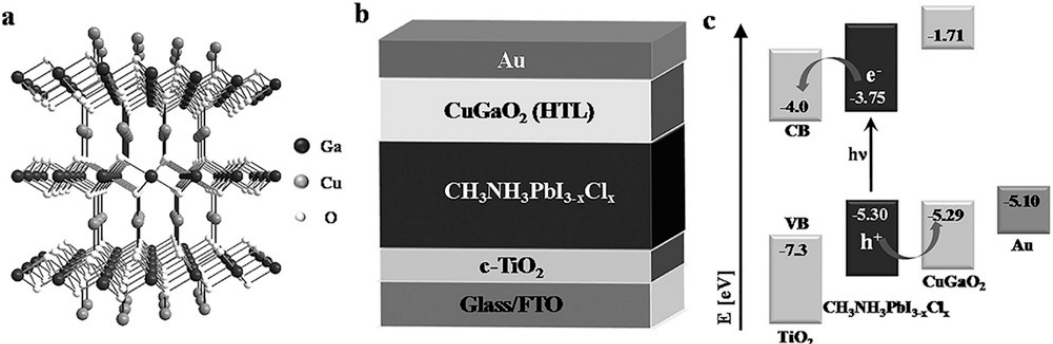
Figure 5. ( a ) Crystal structure of CuGaO 2 , ( b ) schematic illustration of the solar cell device, and ( c ) band diagram of the materials in the device. Reproduced with permission from Ref. [54]. Copyright 2017 Wiley.